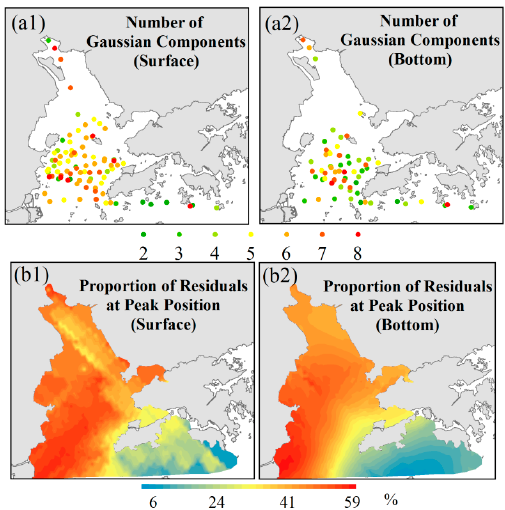
Figure 7. Surface and bottom variation of ( a ) the number of Gaussian components decomposed per spectrum and ( b ) the proportion of residuals from the original absorption at the peak position. Figures in ( b ) were mapped by the Kriging interpolation method based on discrete sampling data. Remote Sens. 2019 , 11 , x FOR PEER REVIEW